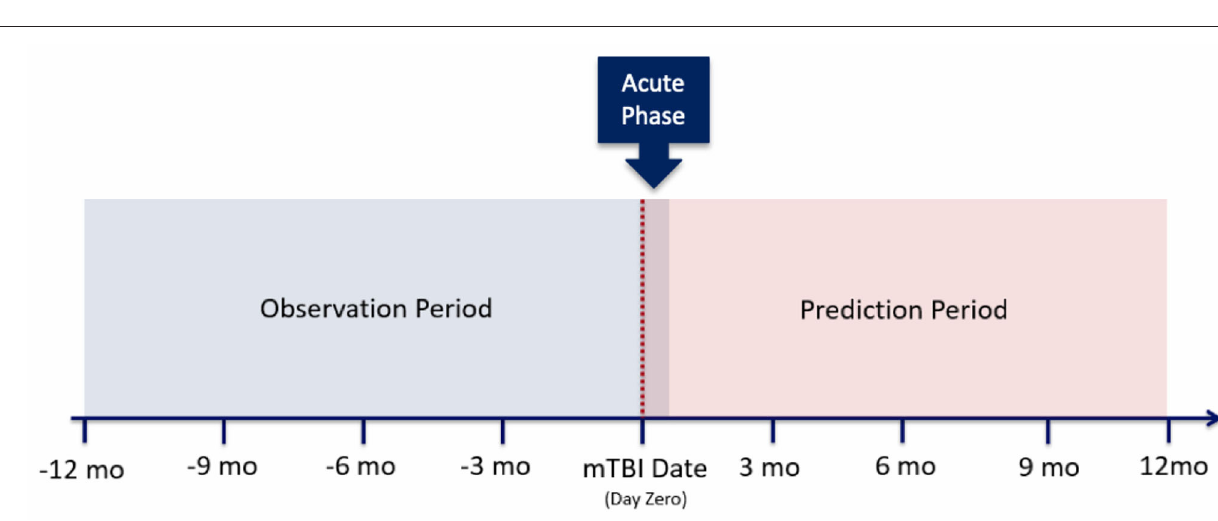
FIGURE 3 | Patient’s clinical trajectory, split into observation and prediction